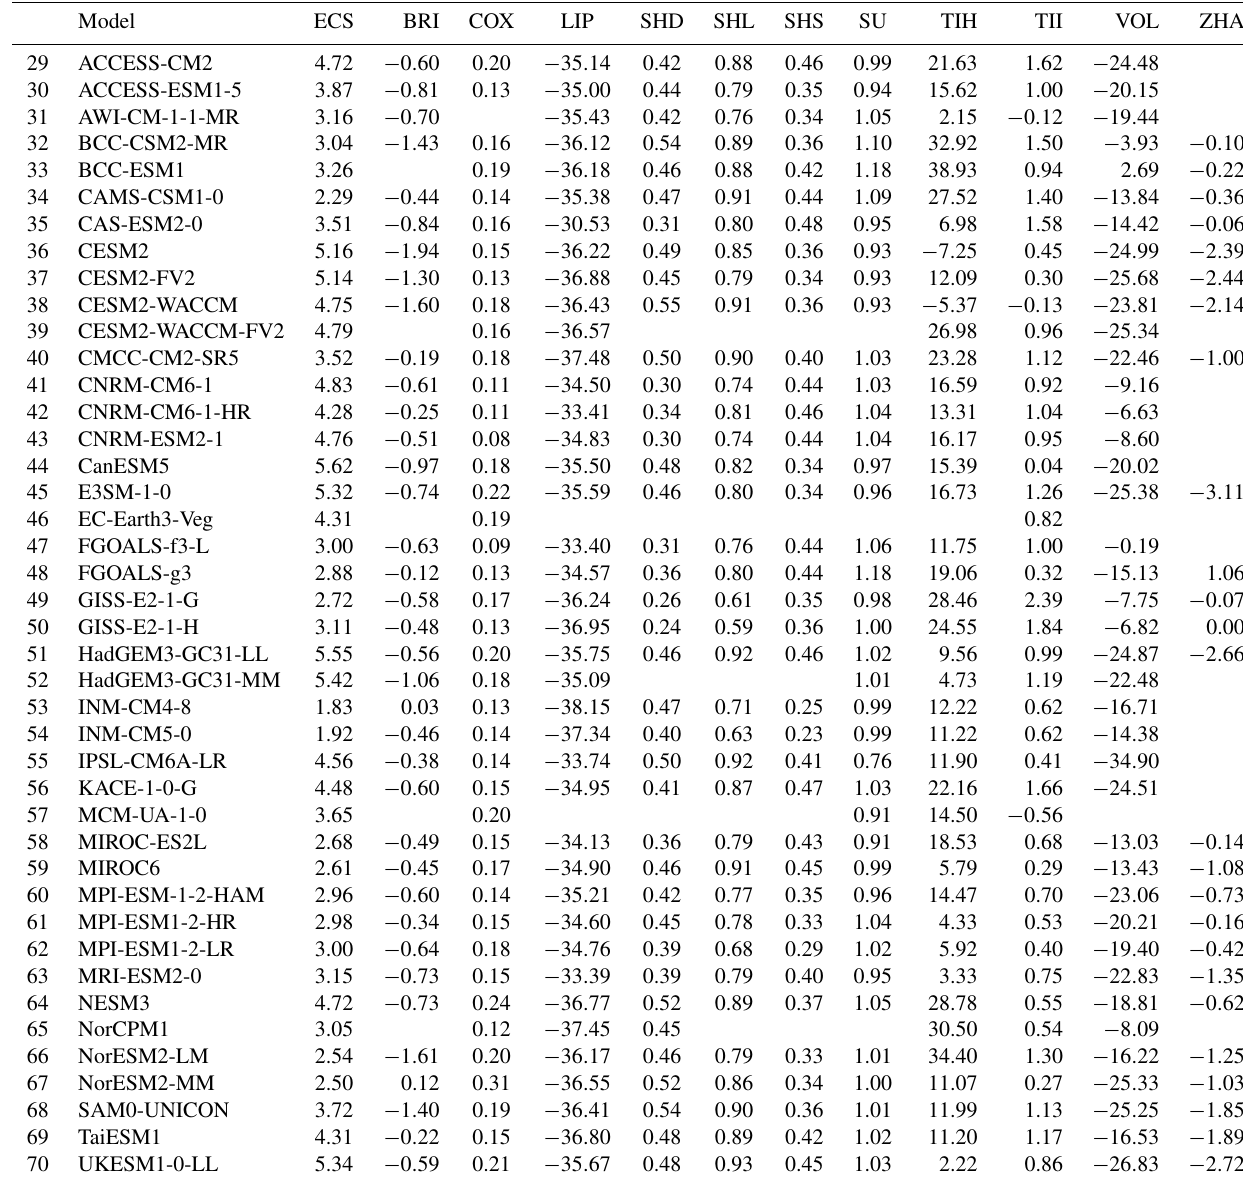
Table A2. As in Table A1 but for the CMIP6